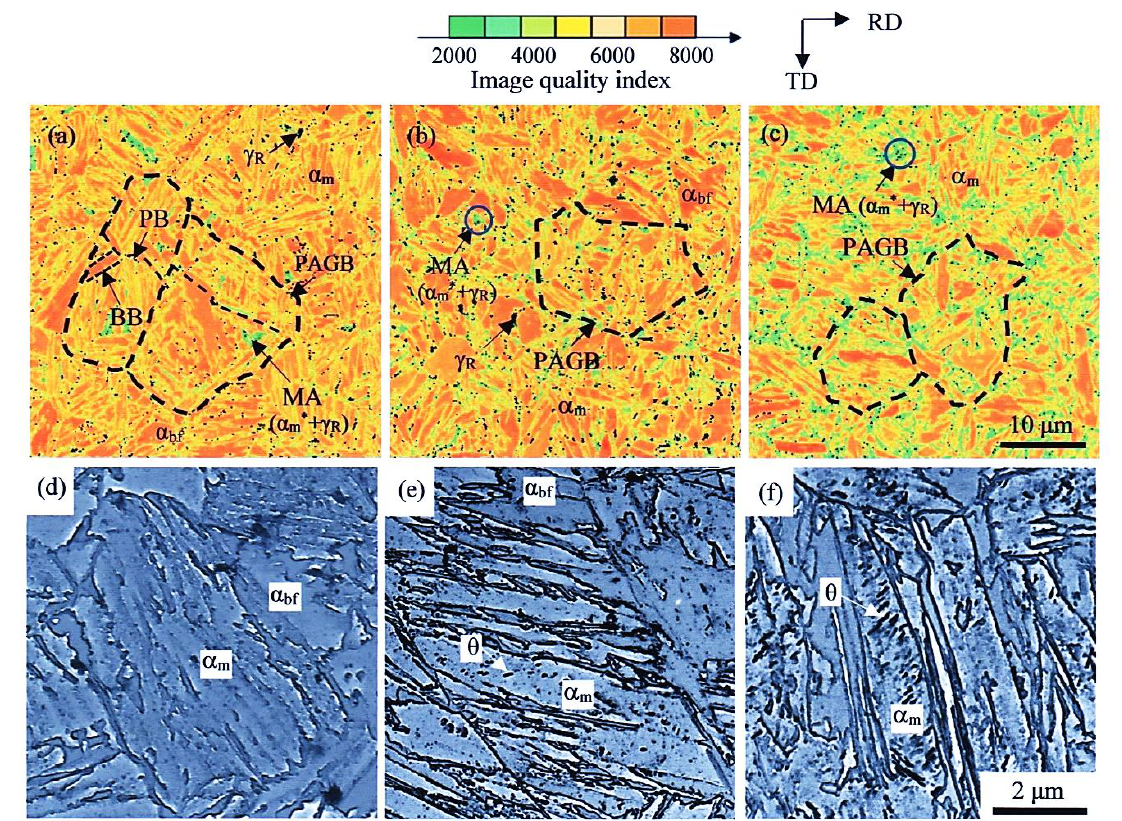
Table 2. Retained austenite characteristics, tensile properties, stretch-formability, and stretch-flangeability of the 1.5Mn, 3Mn, and 5Mn steels subjected to the IT process. Gray color zones correspond to IT temperatures between M s and M f of the steels. Dotted frames correspond to the IT temperatures between M s and M f − 100  C. T